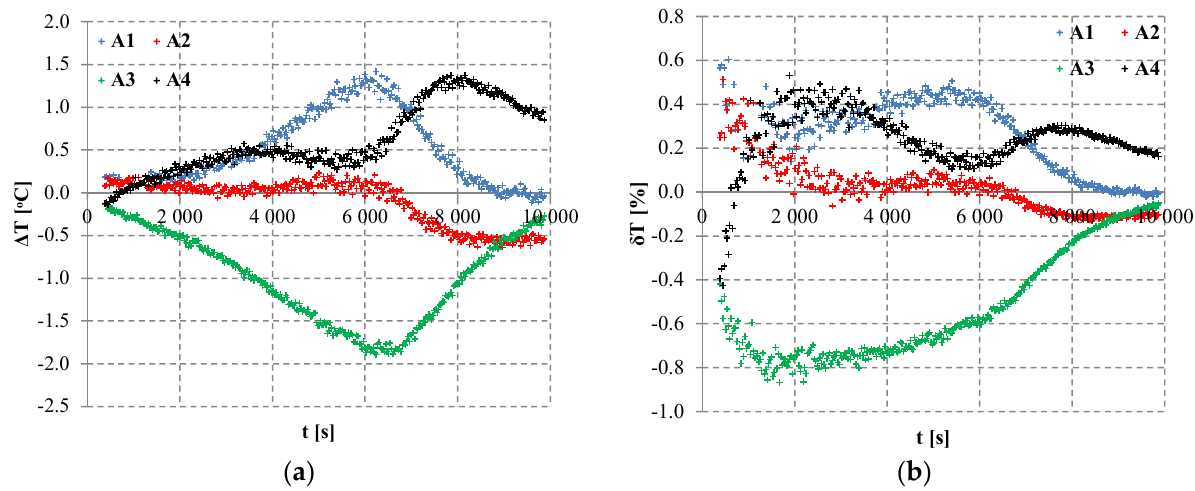
Figure 7. Course of the absolute difference ( a ) and of the relative difference ( b ) for temperature and process p2 in planes A1, A2, A3 and A4.